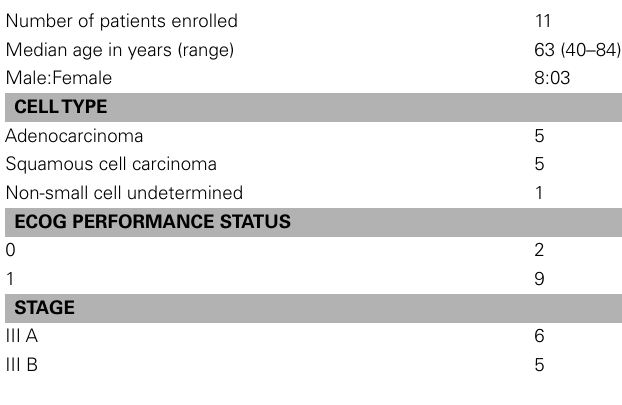
Table 1 | Patient